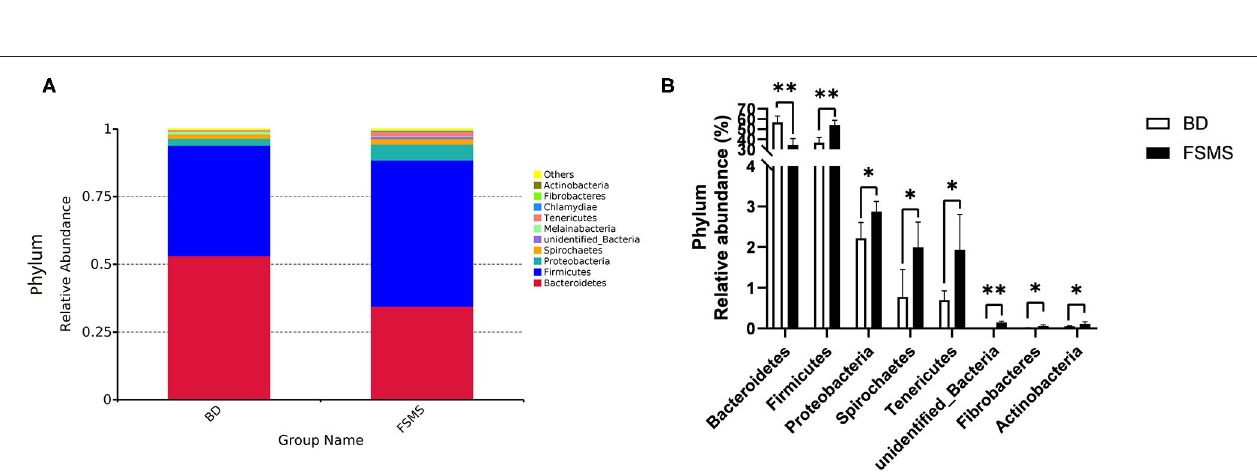
FIGURE 2 | Relative abundance of bacterial phylum in the cecal digesta of pigs (A) . Significantly changed phyla in the cecal digesta (B) . Values were expressed as means ± SEM ( n = 6). Statistical differences were calculated by Duncan: * p < 0.05, ** p < 0.01.